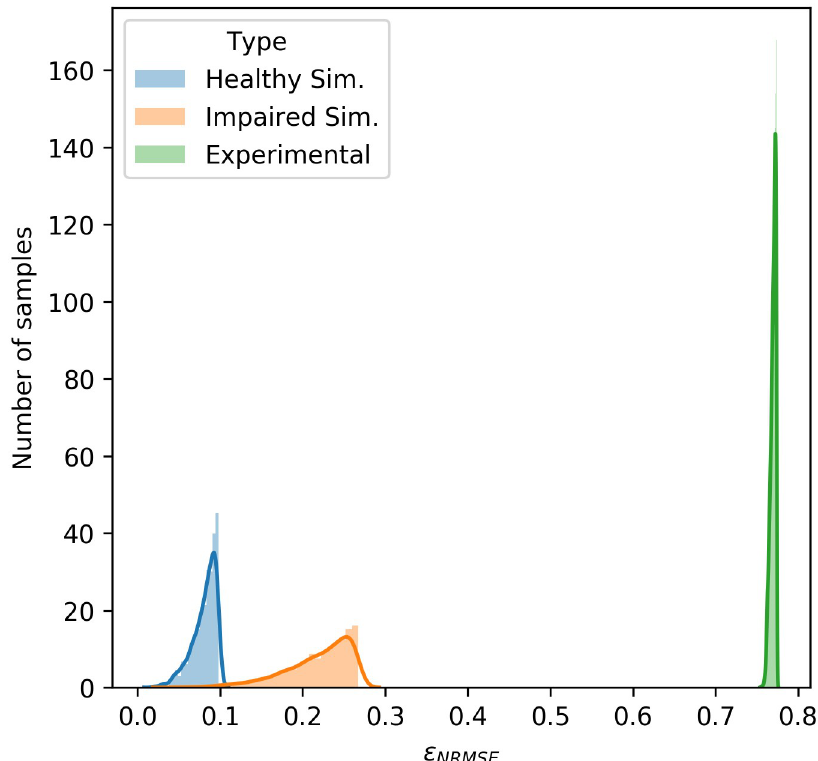
Fig 13. Distribution of ε NRMSE values for the posteriors of each dataset. It can be seen here that the three datasets had very different distributions ε NRMSE values for the samples that made up their respective posteriors. Despite this, the posterior predictive distributions for all datasets were good